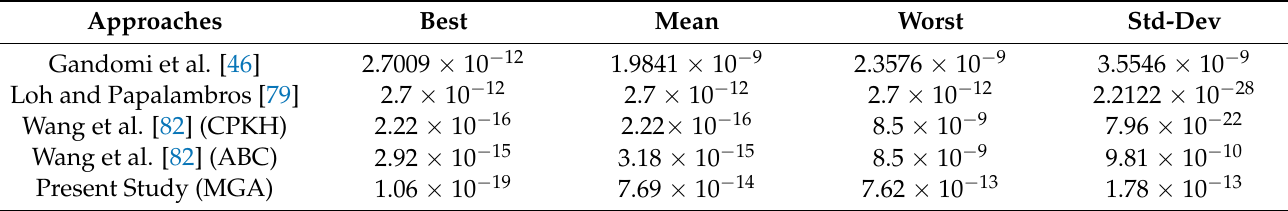
Table 23. Statistical results of different approaches for the gear train design problem.